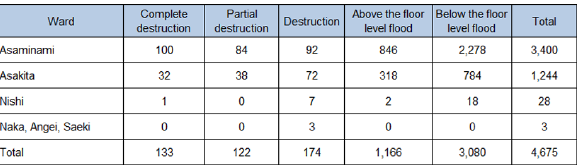
Table 3. House damage(Hiroshima region).